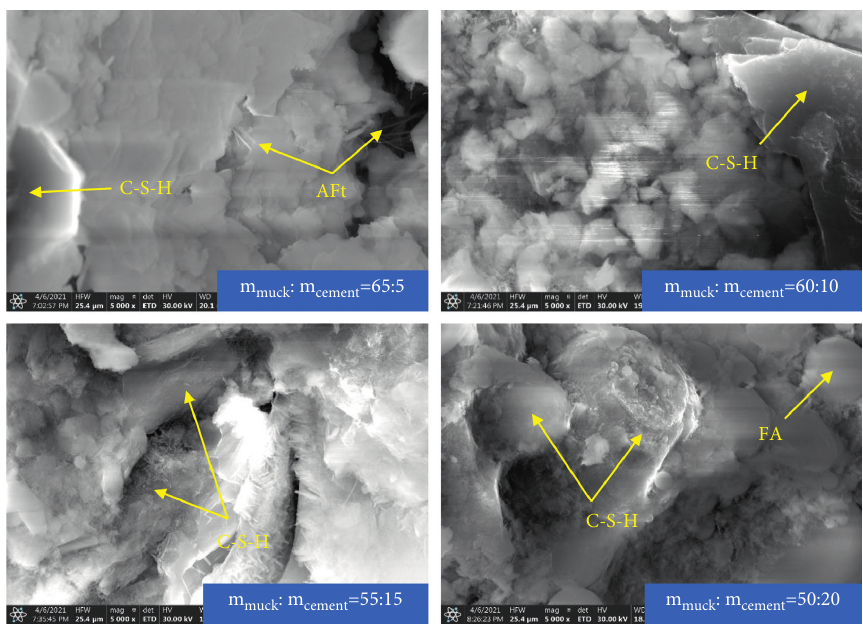
Figure 12: SEM images of nonsintered bricks with different cement